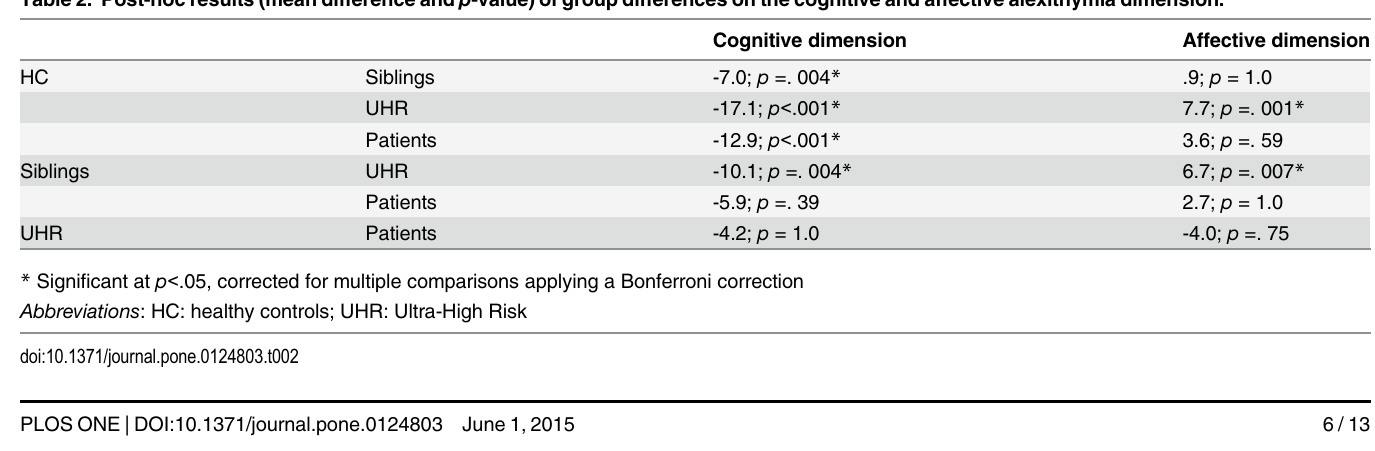
Table 2. Post-hoc results (mean difference and p -value) of group differences on the cognitive and affective alexithymia dimension. HC Siblings